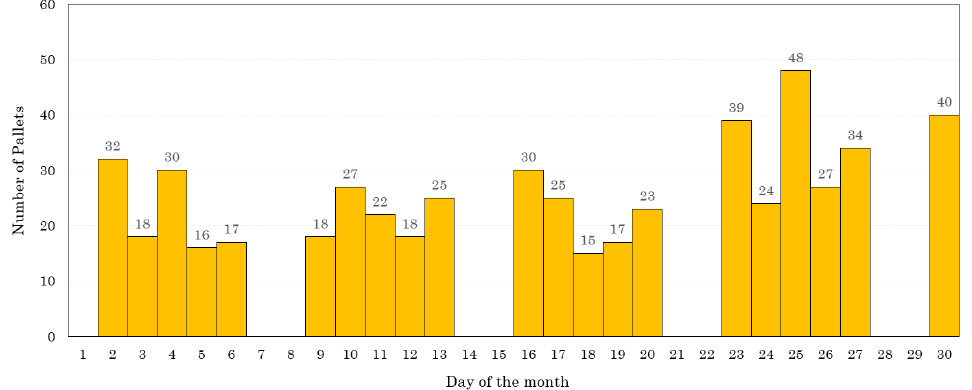
Figure 4. Number of Multi ‐ Code pallets received per day in November 2020.